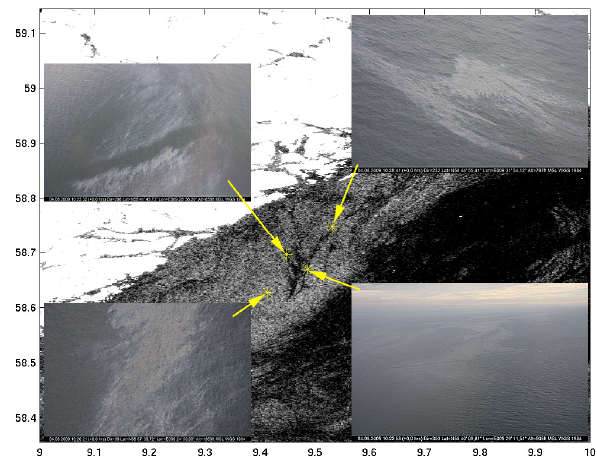
Figure 6: Contrast enhanced Envisat ASAR image on 4 August after the «Full City» accident, superimposed geolocated aerial photos from NCA. Courtesies; Press release as of 4 August 2009 from Nansen Environmental and Remote Sensing Center, Bergen, Norway. Envisat ASAR; © ESA. Aerial photos: www.kystverket.no